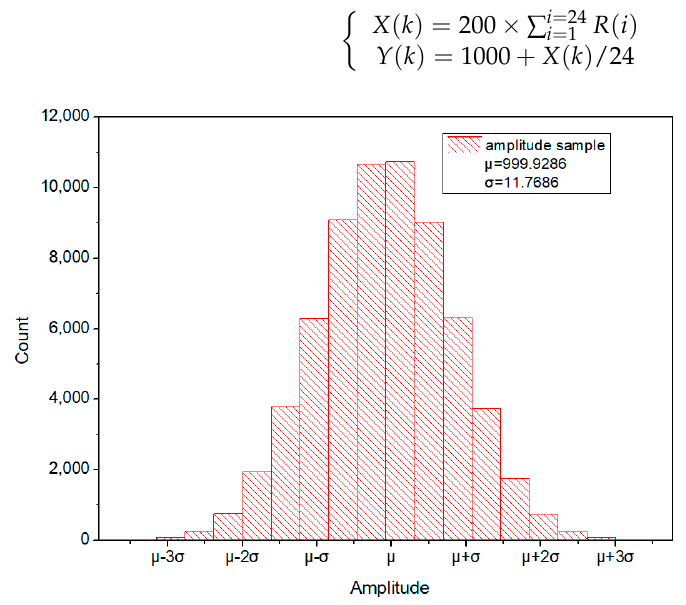
Figure 4. Normal distribution of amplitude samples.